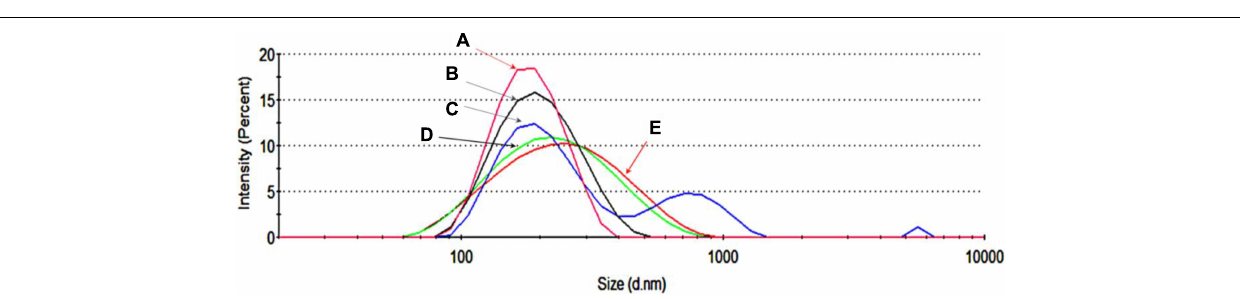
FIGURE 3 | Size distribution by the intensity of extracellular vesicles (EVs) under different conditions. (A) EVs in PBS-TWEEN solution. (B) Electroporated EVs without DNA. (C) Electroporated EVs with DNA. (D) DNA dissolved in MQ water. (E) Electroporated DNA without